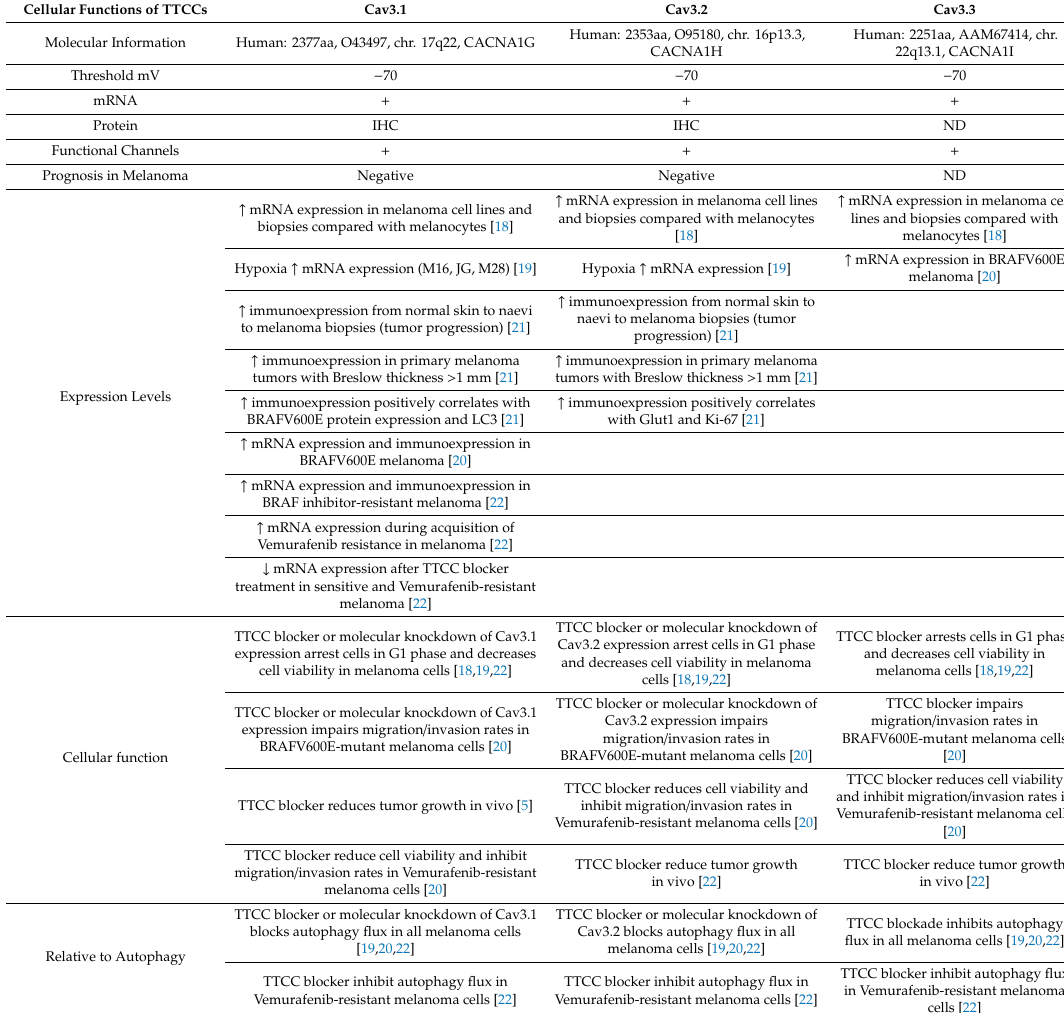
Table 1. T-type calcium channel (TTCC) expression and cellular function in melanoma. ND: not